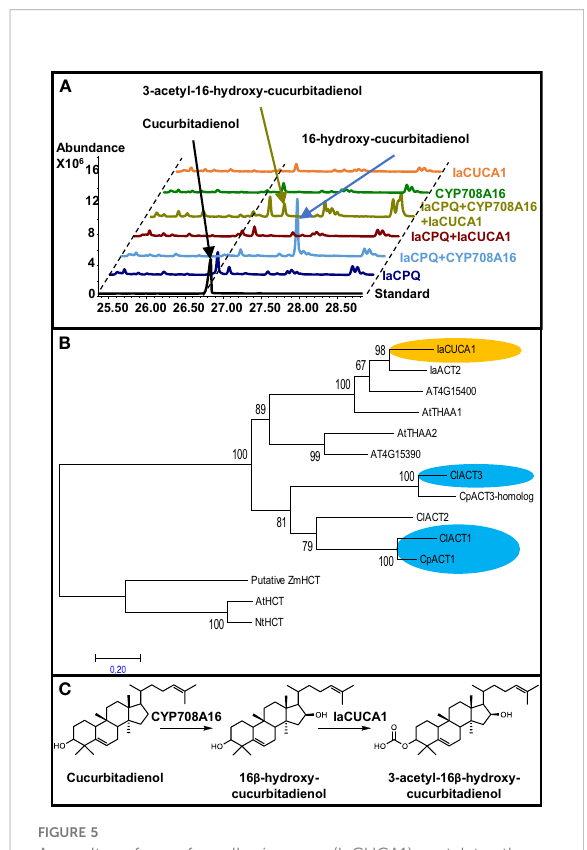
FIGURE 5 An acyltransferase from Iberis amara (IaCUCA1) acetylates